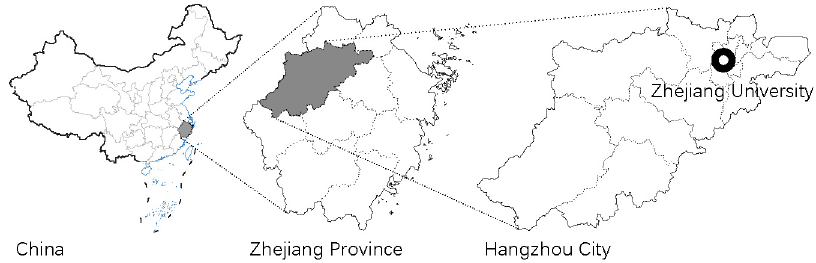
Figure 1. Zhejiang University, Hangzhou City, Zhejiang Province, China.